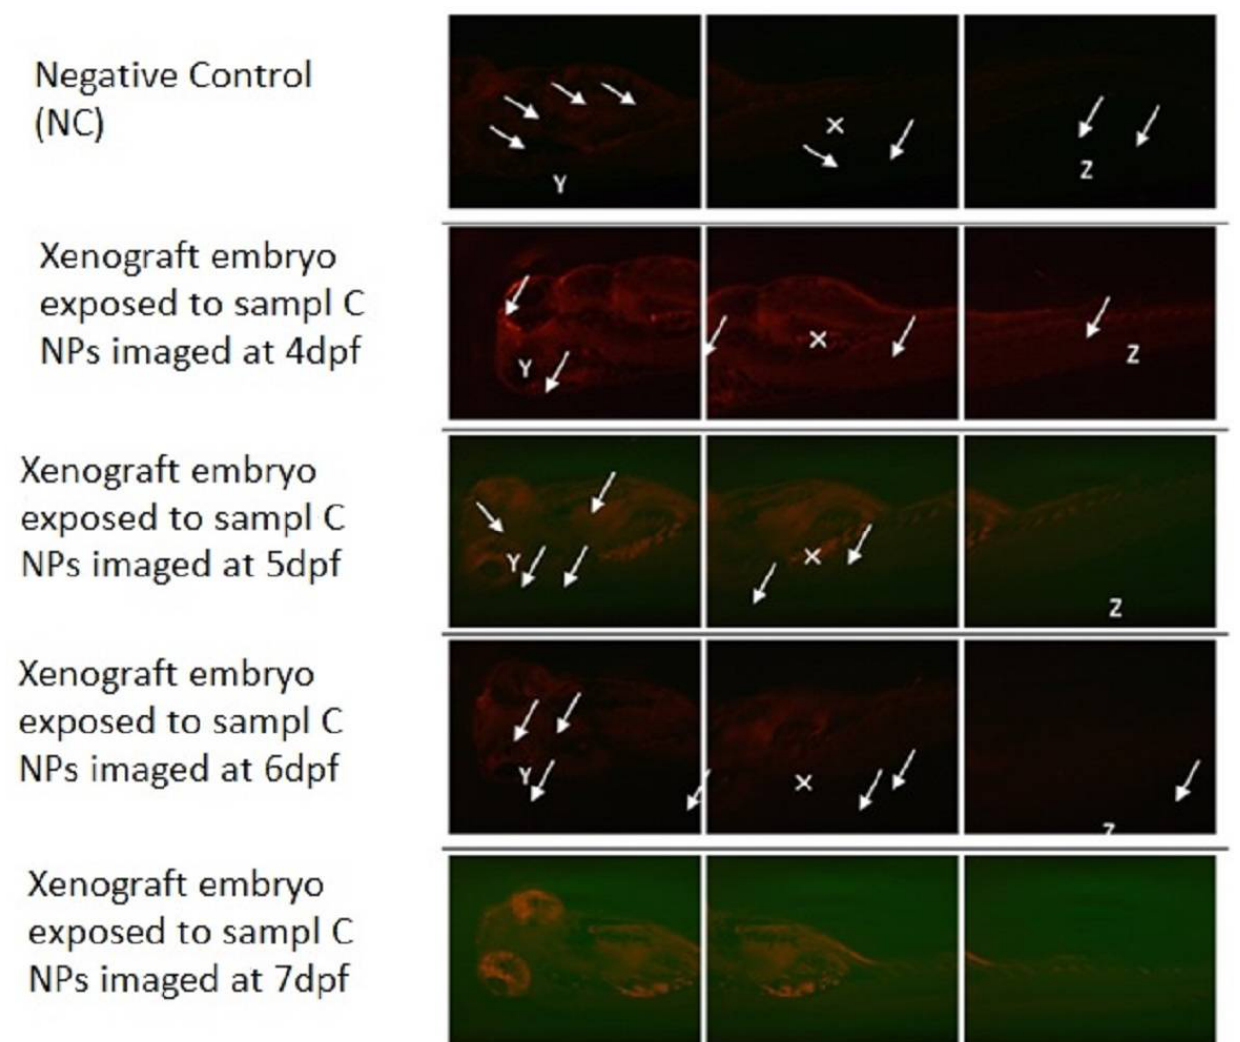
Figure 10. Xenograft model exposed to sample C PLGA-PEG-PLGA NPs. Representative fluorescence images of zebrafish screening at 4 dpf to 7 dpf using fluorescent microscopy and investigation of fluorescent K562 cells proliferation (white solid arrows) throughout the animal body (Y—eyes; X—yolk sac; Z—tail) using mCherry fluorescence filter after treating zebrafish embryos with sample C PLGA-PEG-PLGA NPs (0.001 mg/mL). Original magnification 100×.